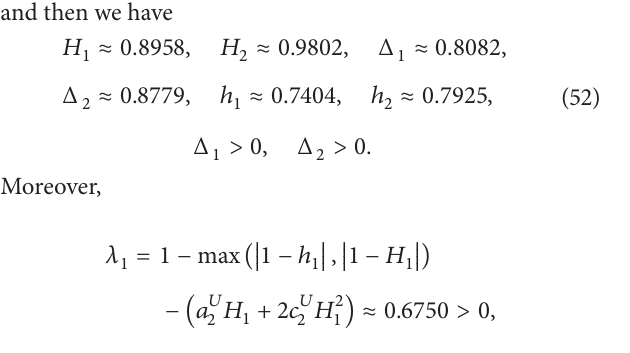
Figure 3: Uniformly asymptotic stability. (a) Time-series of 𝑥 ∗ 1 (𝑛) and 𝑥 1 (𝑛) with initial values 𝑥 ∗ 1 (−1) = 0.79 and 𝑥 ∗ 1 (0) = 0.80 and 𝑥 1 (−1) = (0) = 0.92 for 𝑛 ∈ [0, 100] , respectively. (b) Time-series of 𝑥 ∗ 0.83 and 𝑥 1 (0) = 0.79 and 𝑥 (−2) = 0.81 , 𝑥 (−1) = 0.79 , and 𝑥 𝑥 ∗ 2 2 2